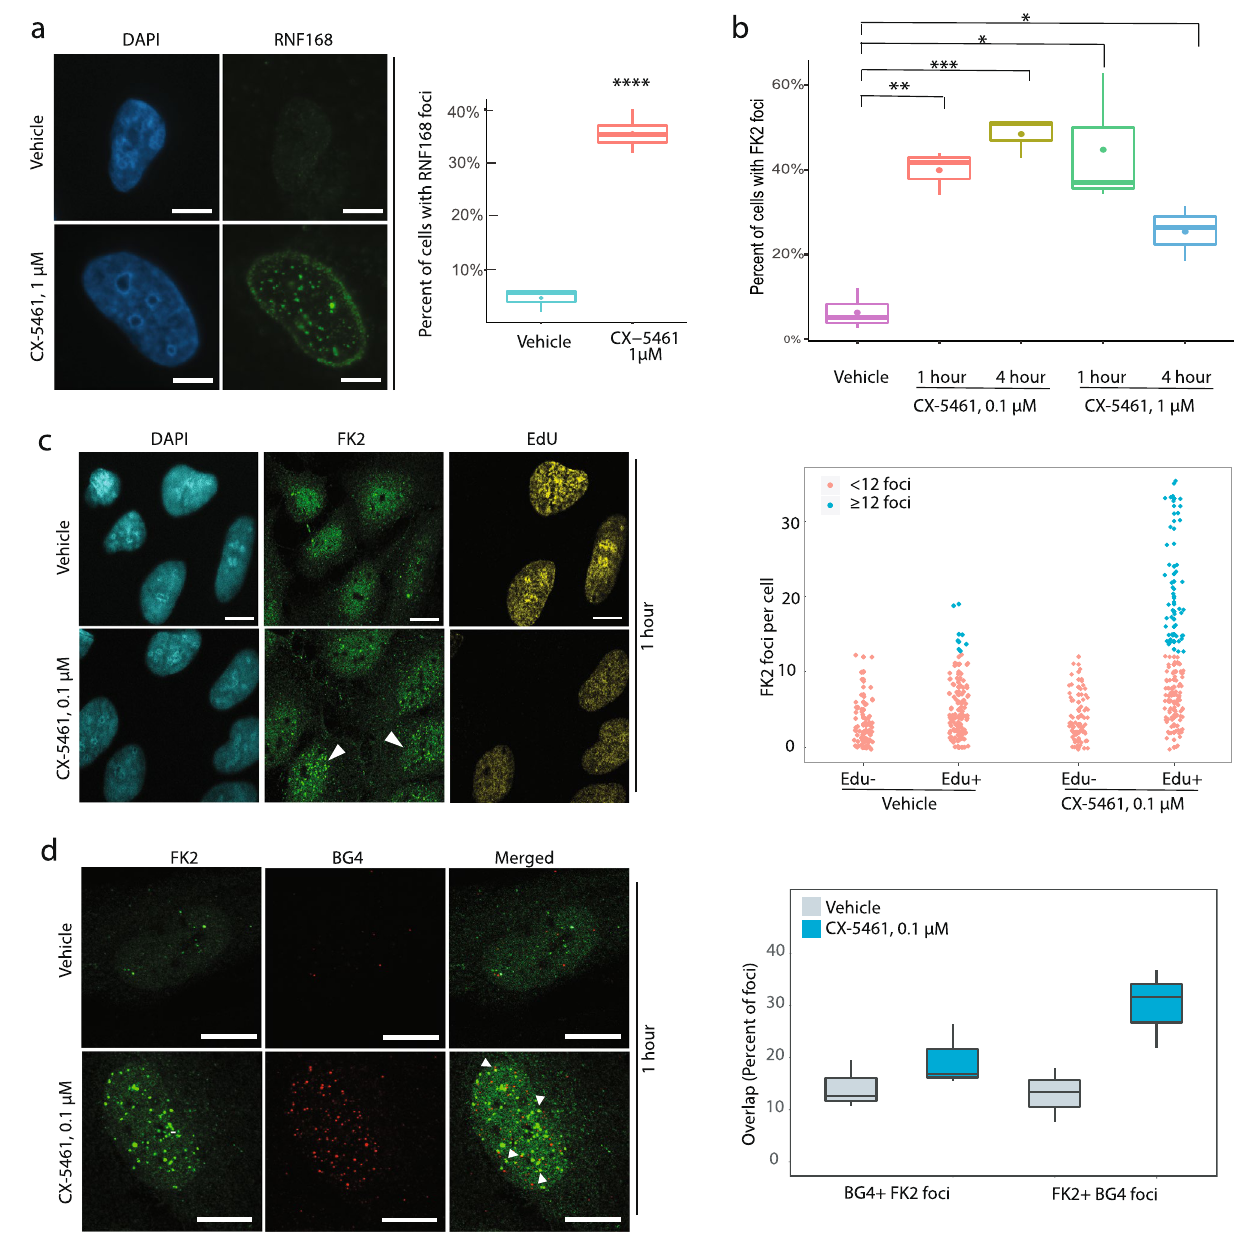
Figure 3. DDR-associated ubiquitin signaling is activated by CX-5461 treatment. ( a ) RNF168 foci were induced in U2OS cells after 4 h of incubation with 1 µM CX-5461. Left panel shows the images of RNF168 and DAPI staining. Right panel shows the percent of cells with RNF168 foci after CX-5461 and vehicle treatments. **** p < 0.0001 (two-tailed unpaired t-test).RNF168 foci were manually counted, and RNF168 foci positive cells are cells with foci number ≥ 3 per nucleus. ( b ) FK2 foci were induced in U2OS cells after CX-5461 treatment at indicated doses and durations of drug treatment. The box plots show the median, 25% and 75% quantiles. The mean is indicated by a dot inside the box plot. * p < 0.05, ** p < 0.01, *** p < 0.001 (two-tailed unpaired t-test). ( c ) CX-5461-induced FK2 foci are enriched in S-phase of cell cycle. U2OS cells were incubated with 10 µM EdU for 20 min to label S-phase cells followed by incubation with vehicle or 0 . 1 µM CX-5461 for 1 h. Foci were visualized using confocal microscopy. The graph on the right shows the number of FK2 foci per cell in Edu- (negative) and Edu + (positive) cells. Cells with 12 or more FK2 foci are shown as blue and the cells with less than 12 FK2 foci per cell as red. The difference in the number of FK2 foci in Edu + cells is significant between CX5461 and vehicle treatments ( p < 0.0001, TukeyHSD test). ( d ) Co-localization of FK2 foci and BG4 foci in U2OS cells after 1 h of treatment with either vehicle or CX-5461 at the indicated dose. The graph on the right shows the overlap of BG4 and FK2 foci as either percent of total FK2 foci that are also BG4 + (BG4 + FK2 foci) or percent of total BG4 foci that are also FK2 + (FK2 + BG4 foci). Scale bars in all experiments represent 10 µM. Pictures are representative of at least three independent experiments. In each experiment, at